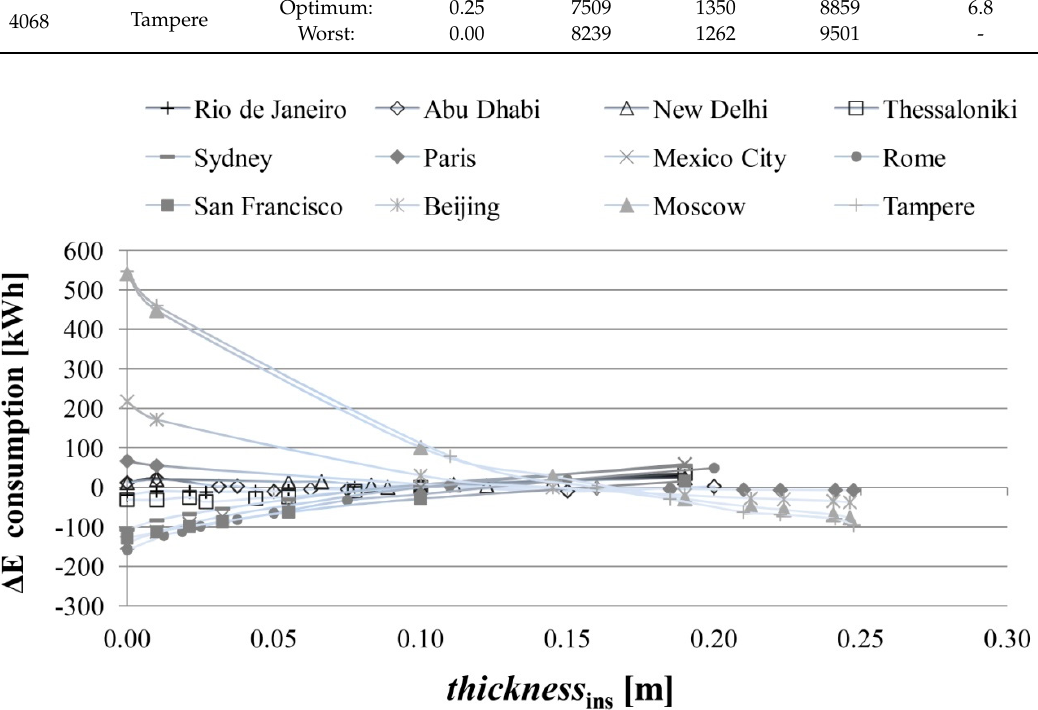
Figure 6. Variation of the annual building HVAC energy consumption difference compared to the standard scenario with varying only roof thermal insulation thickness in each climate zone with “cool roof”.